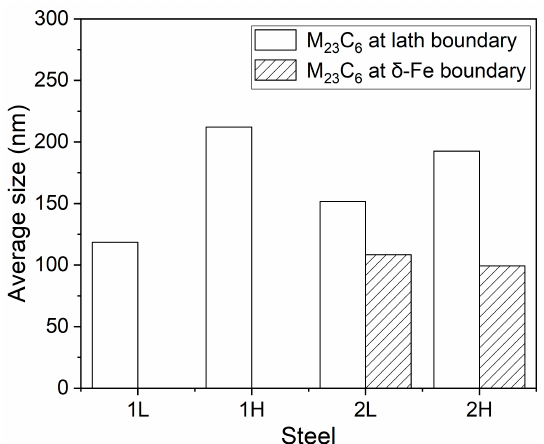
Figure 9. The average size of M 23 C 6 precipitates at martensite lath boundary and δ -ferrite boundary in each sample.